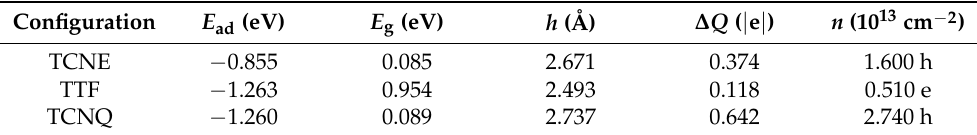
Figure 2. The optimized ground state atomic structures of the most stable configurations of the ( a ) TCNE, ( b ) TTF, or ( c ) TCNQ molecules adsorbed g−ZnO systems. The upper is the top view, and the bottom is the side.